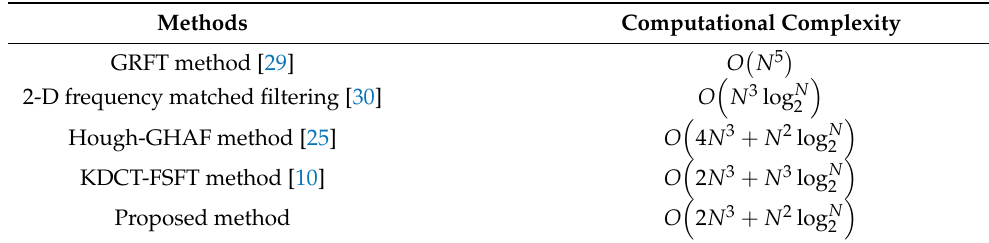
Table 1. Comparisons of computational